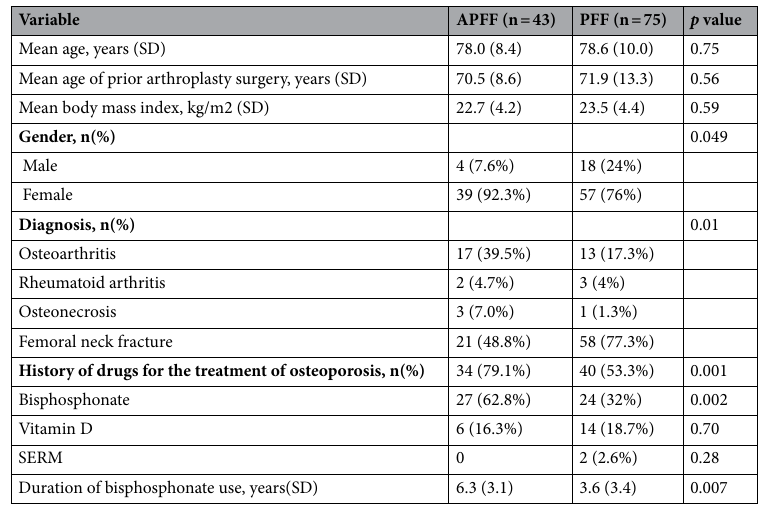
Table 1. Characteristics of patients with atypical periprosthetic femoral fracture (APFF) and typical periprosthetic femoral fracture (PFF). SERM selective estrogen receptor modulator.